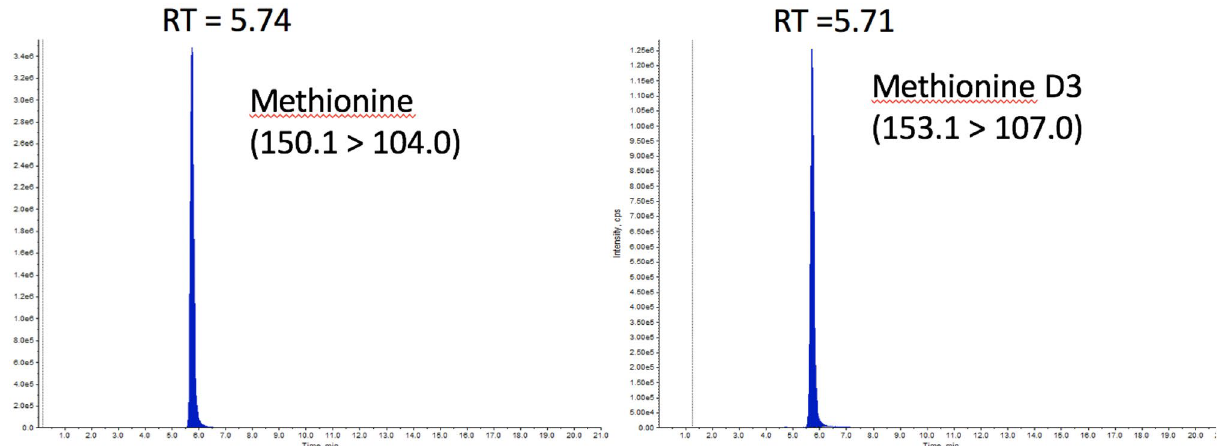
Figure 6. Methionine presence in fractionated “compound X” as observed with LC–MS and aided by an internal standard for retention time confirmation. Conditions are described in “Methods” section (mass